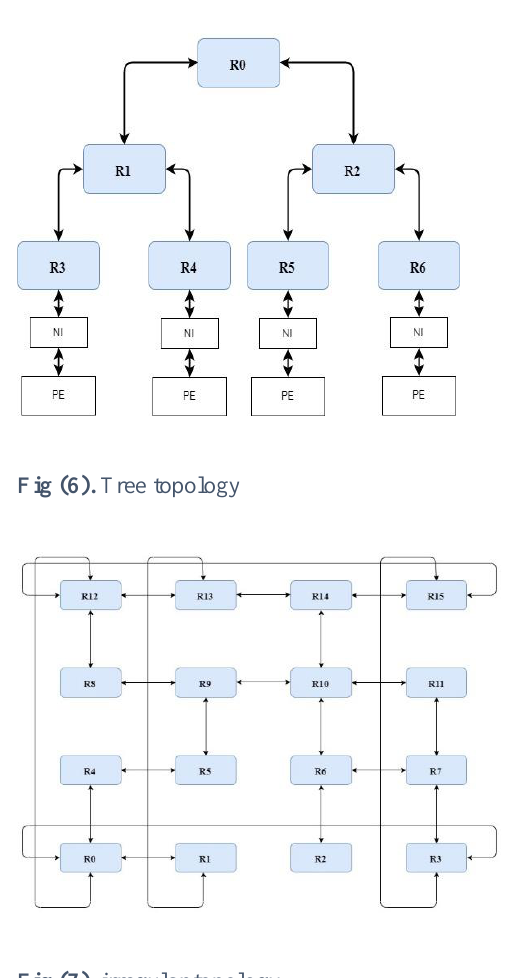
To design the routing algorithm for the network, the choosing of topology is the principle step. The performance of the routing algorithm depends on the topology on which it’s implemented and also on the number of routers in the topology. When the same algorithm is implemented on mesh 4×4, and mesh 8×8 have different performance [28].